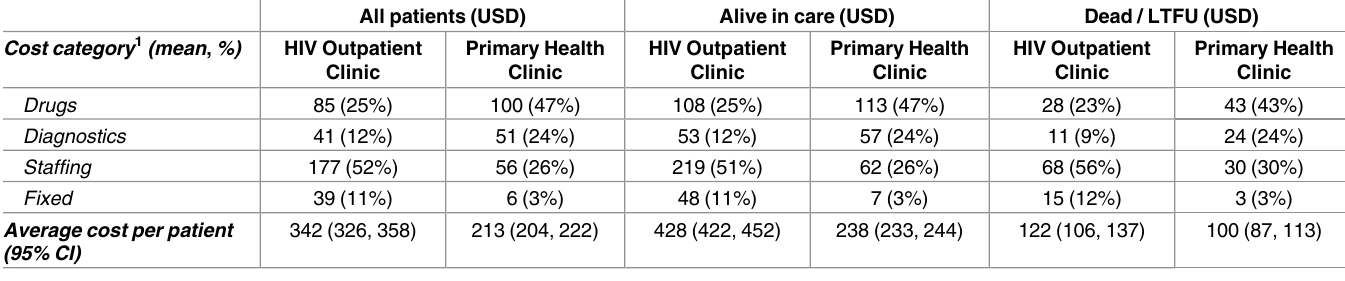
Table 5. Mean 12 month cost per patient (USD) by outcome and facility, broken down by cost